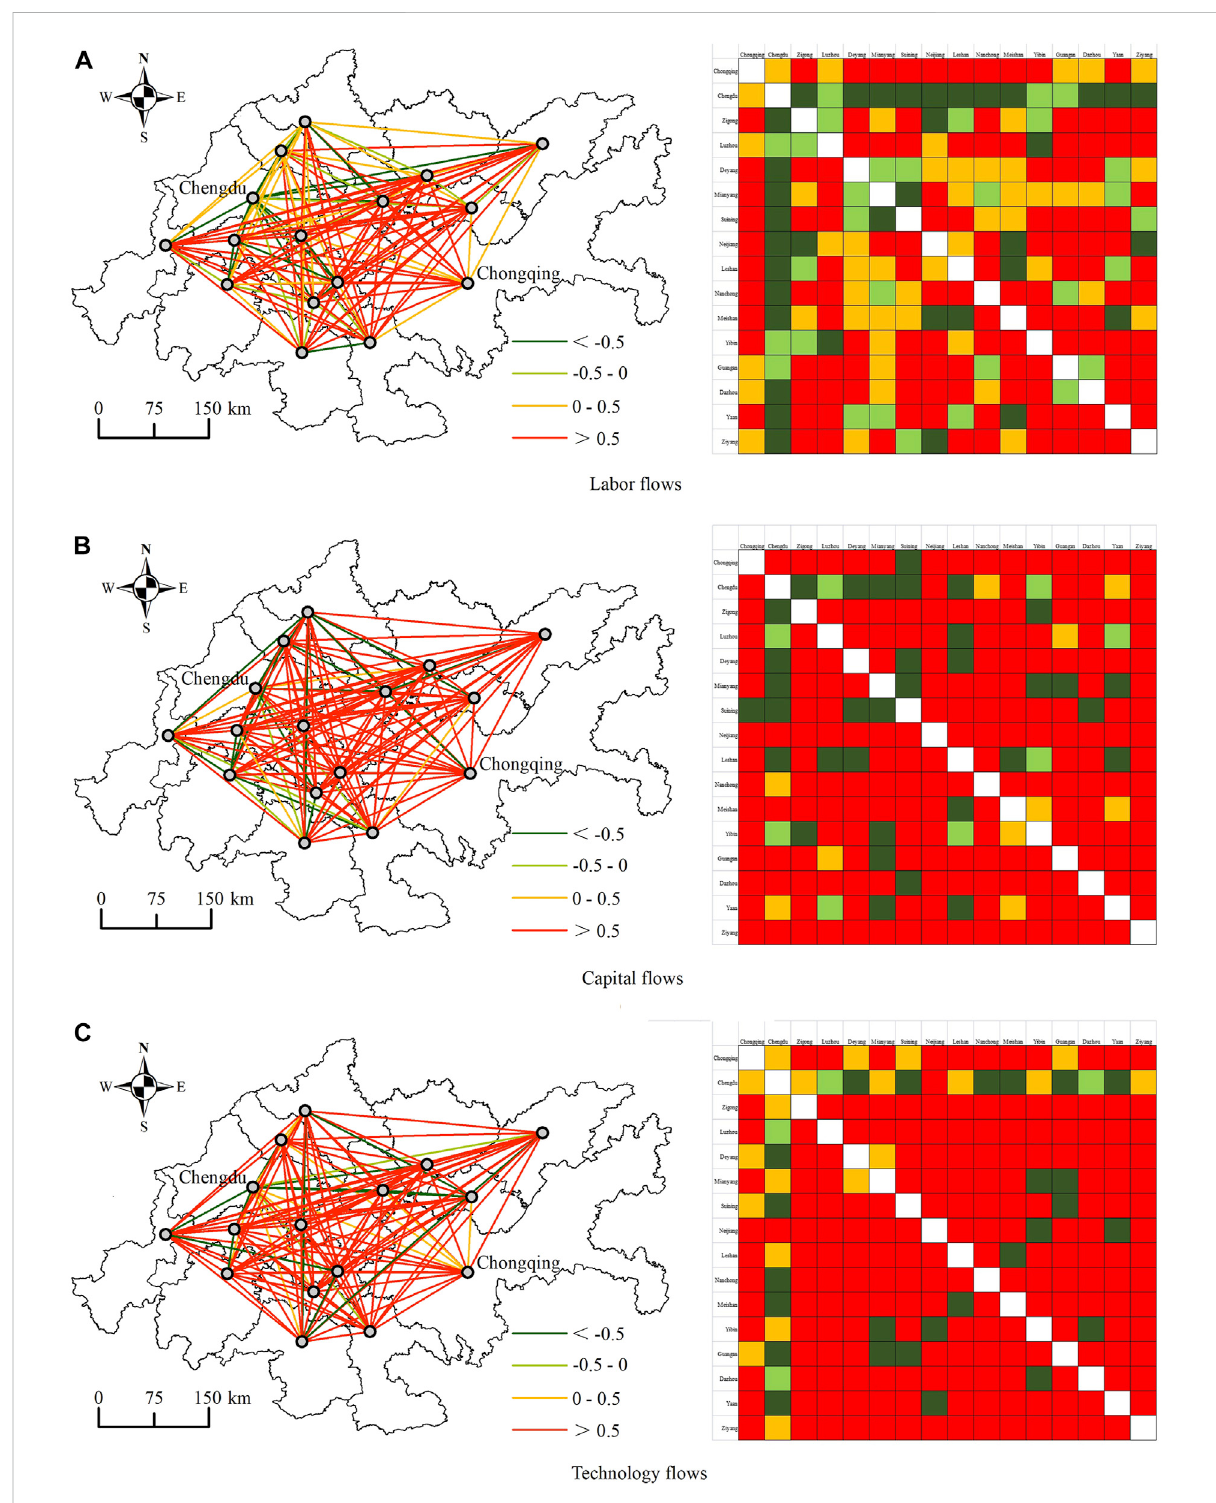
FIGURE 4 The FFBI of labor, capital and technology fl